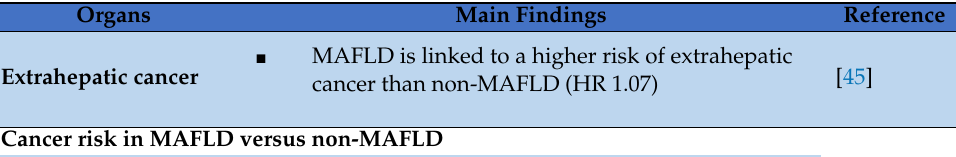
Table 2. Major findings on the relationship between MAFLD and extrahepatic cancers. Main